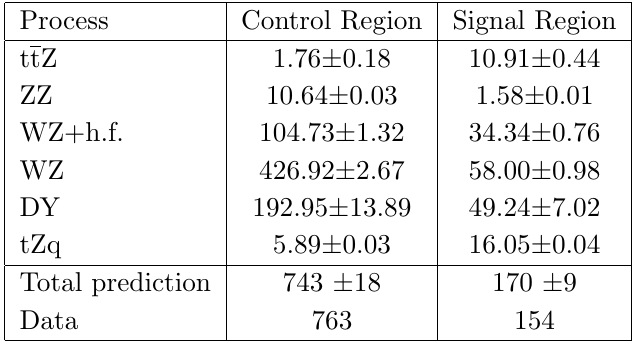
Table 2 . The number of events remaining for each process, after all selections have been applied, in the control and signal regions for the tZq-SM shape analysis. WZ+h.f. denotes WZ + heavy